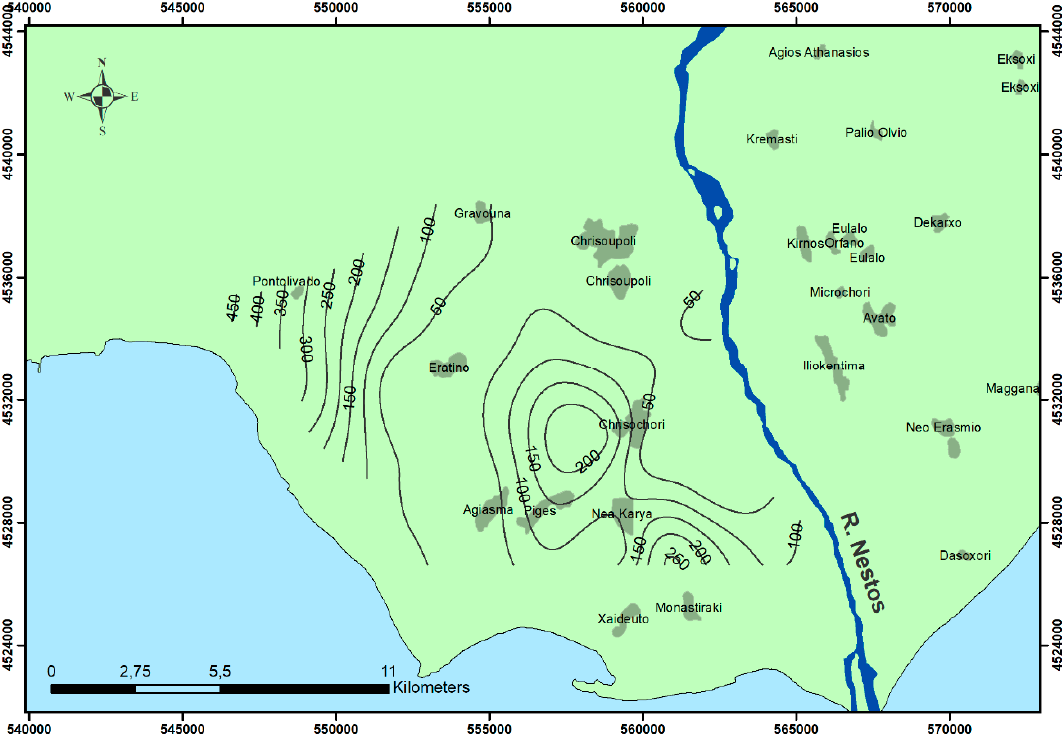
Figure 15. Chloride ion (Cl − ) distribution map (mg/L) of the confined aquifer (May 2019).